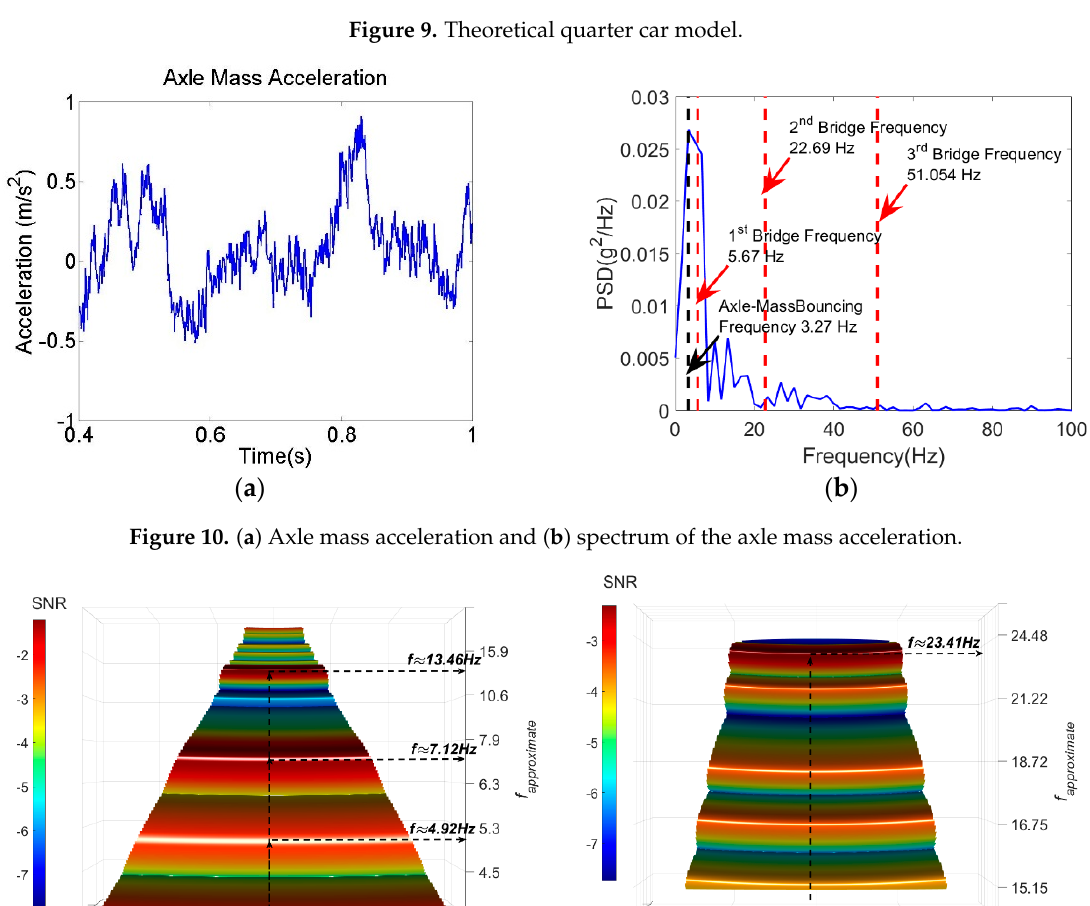
Figure 11. SNR-surface plots for the vehicle acceleration ( a ) [4 Hz–25 Hz]. ( b ) [15 Hz–25 Hz].